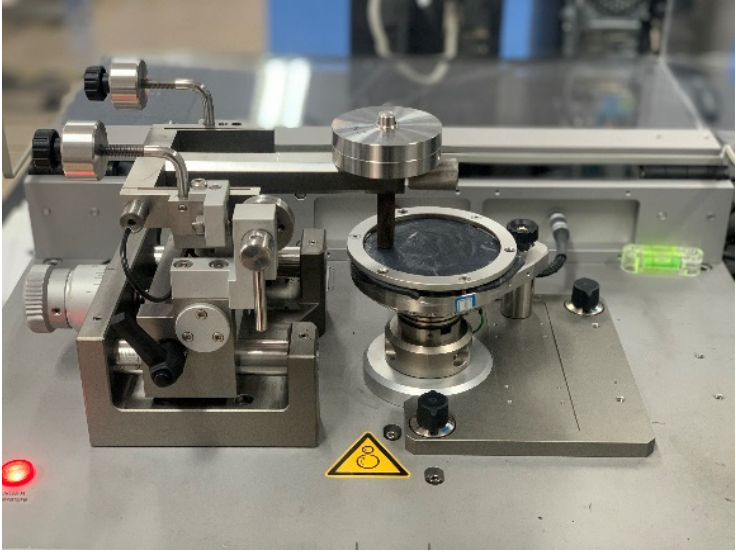
Figure 2. Configuration of the CSM wear experiment.